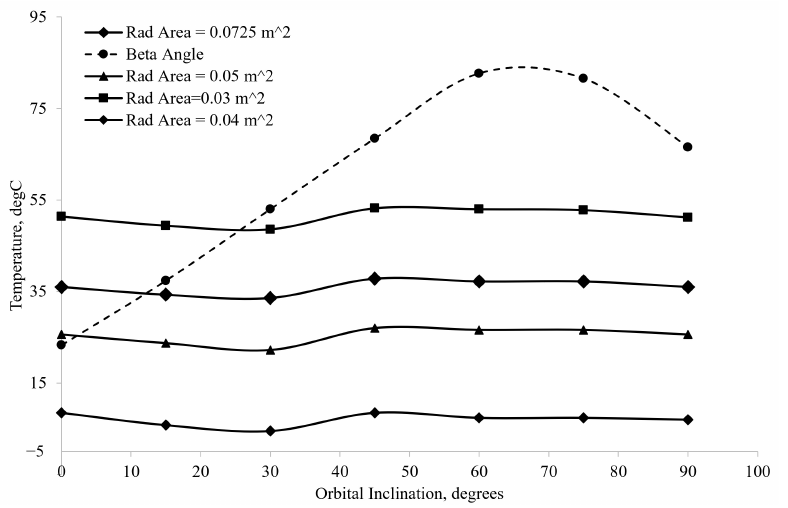
Figure 24. BMR temperature variation with inclination and beta angle—Worst cold